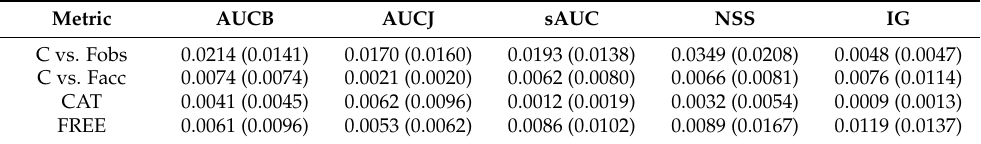
Table 2. Mean r 2 correlation coefficients (and standard deviation) for each heat map comparison metric across all image complexity metrics.